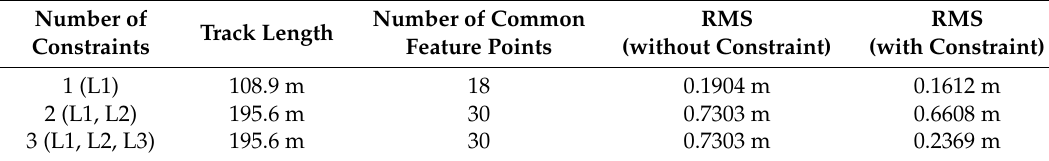
Table 2. RMS of adding different numbers of distance constraints.